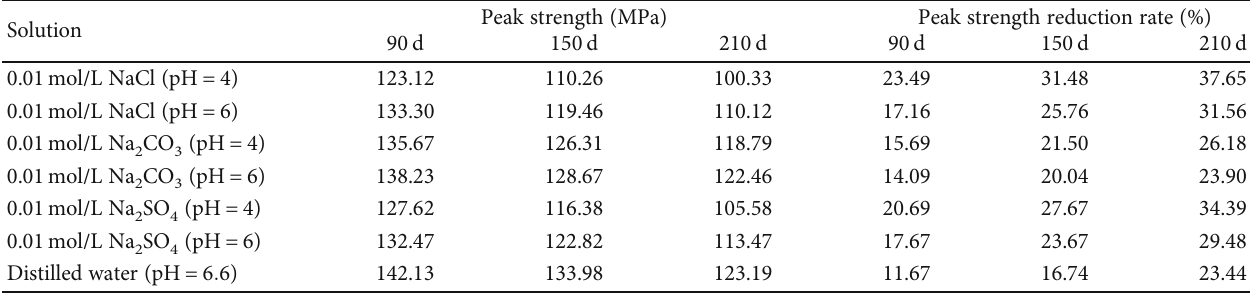
Table 3: Peak strength of limestone under coupled MHC e ff ects in uniaxial compression tests.